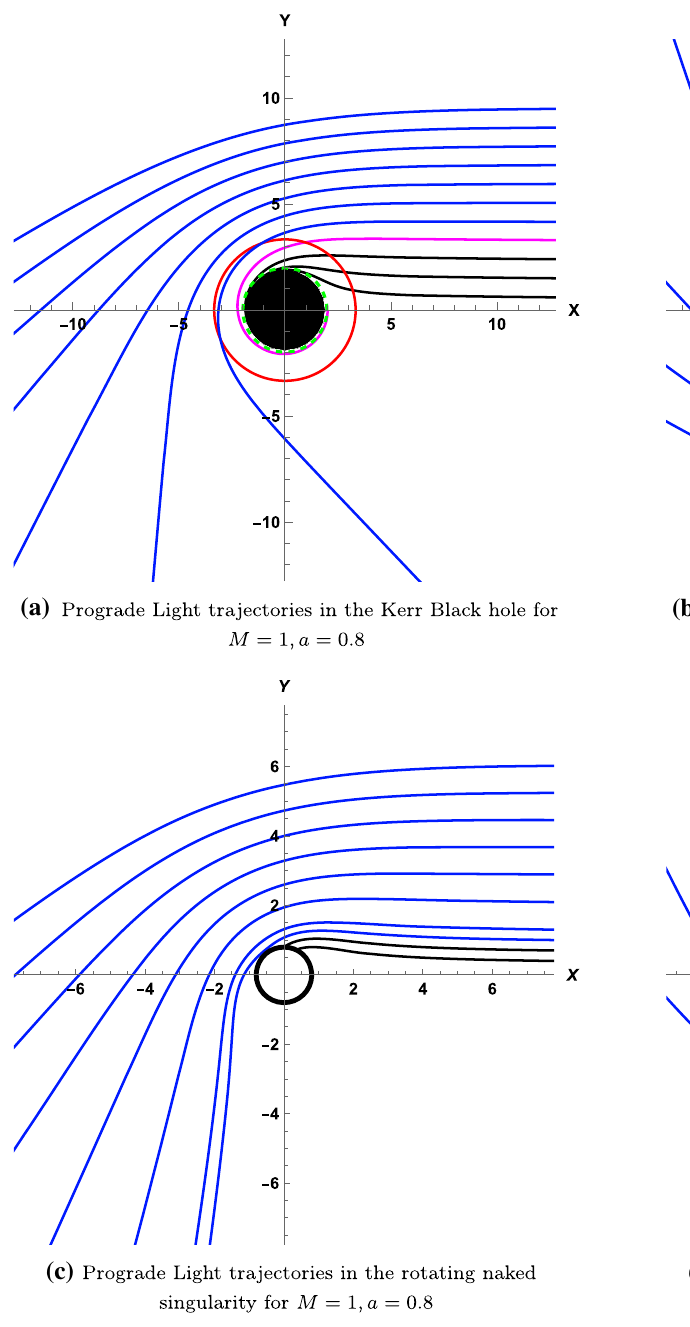
Fig. 3 a , b and c , d Show the lensing of null trajectories in the equato- rial plane of a RNS and Kerr black hole, respectively. In this figure, the spinaxesofthecompactobjectspointoutofthepage.Here,theredsolid circle and green dashed circle denote the critical impact parameters and photon spheres, respectively. The scattered light rays are represented